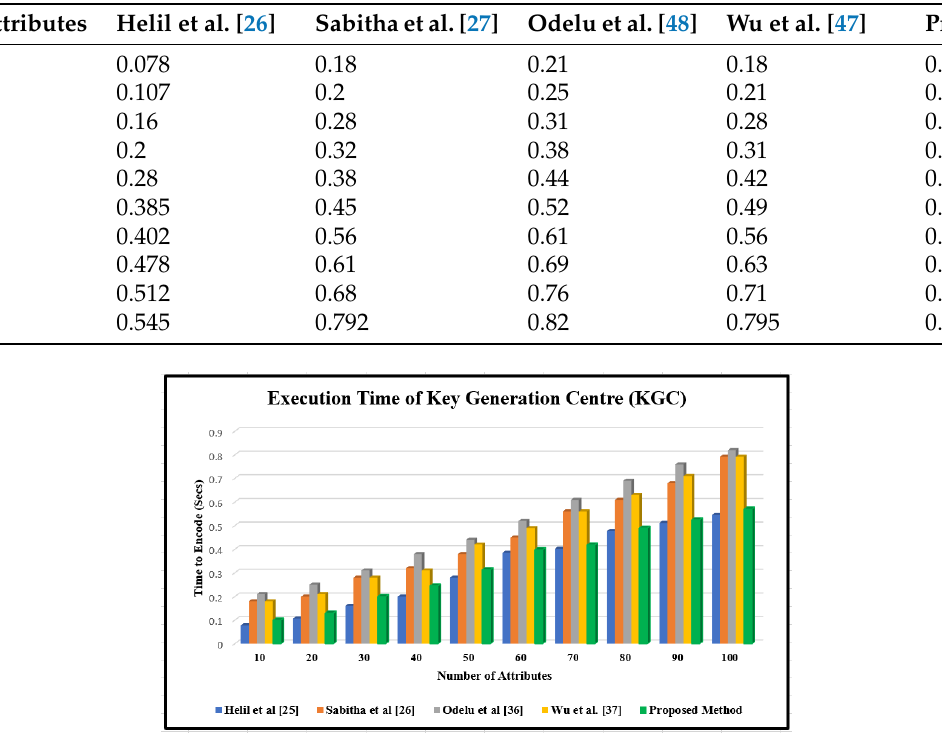
Figure 7. Execution time of the key generation centre